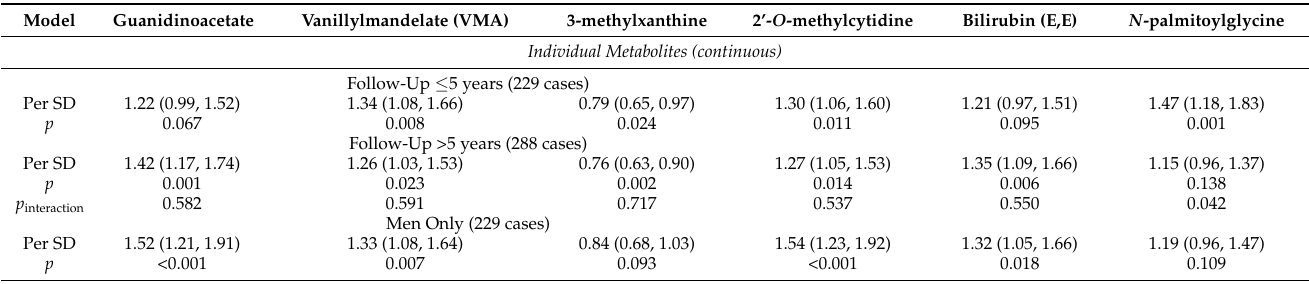
Table 3. OR and 95% CI for metabolites associated with colorectal cancer risk at FDR < 0.2 in the Cancer Prevention Study II Nutrition Cohort, stratified by follow-up time and participant sex a.